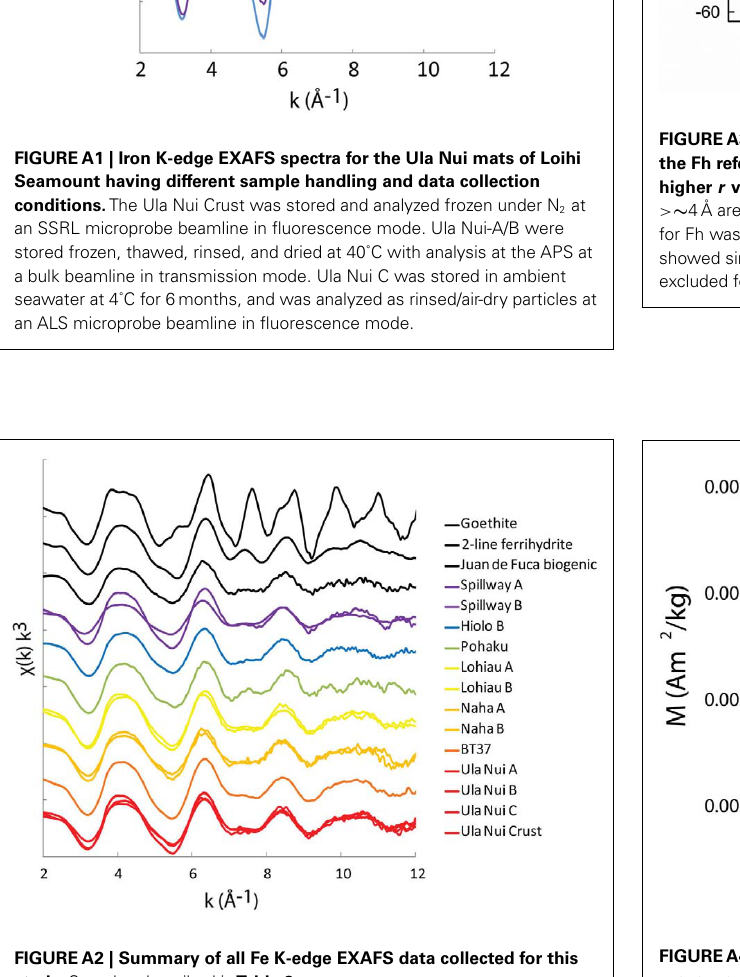
FIGUREA2 | Summary of all Fe K-edge EXAFS data collected for this study. Samples described in Table 2 .